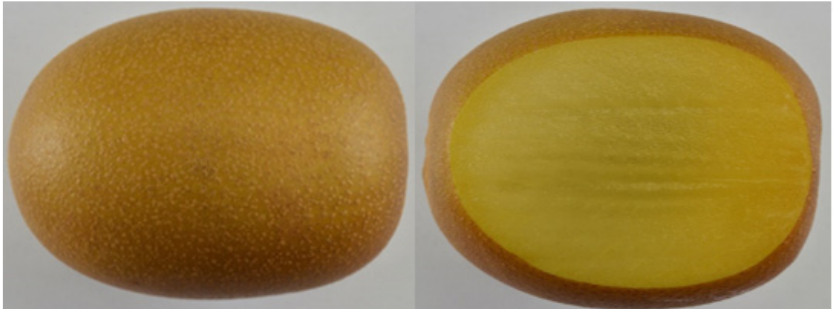
Figure 1. Example of unpeeled ( Left ) and peeled ( Right ) kiwifruit.